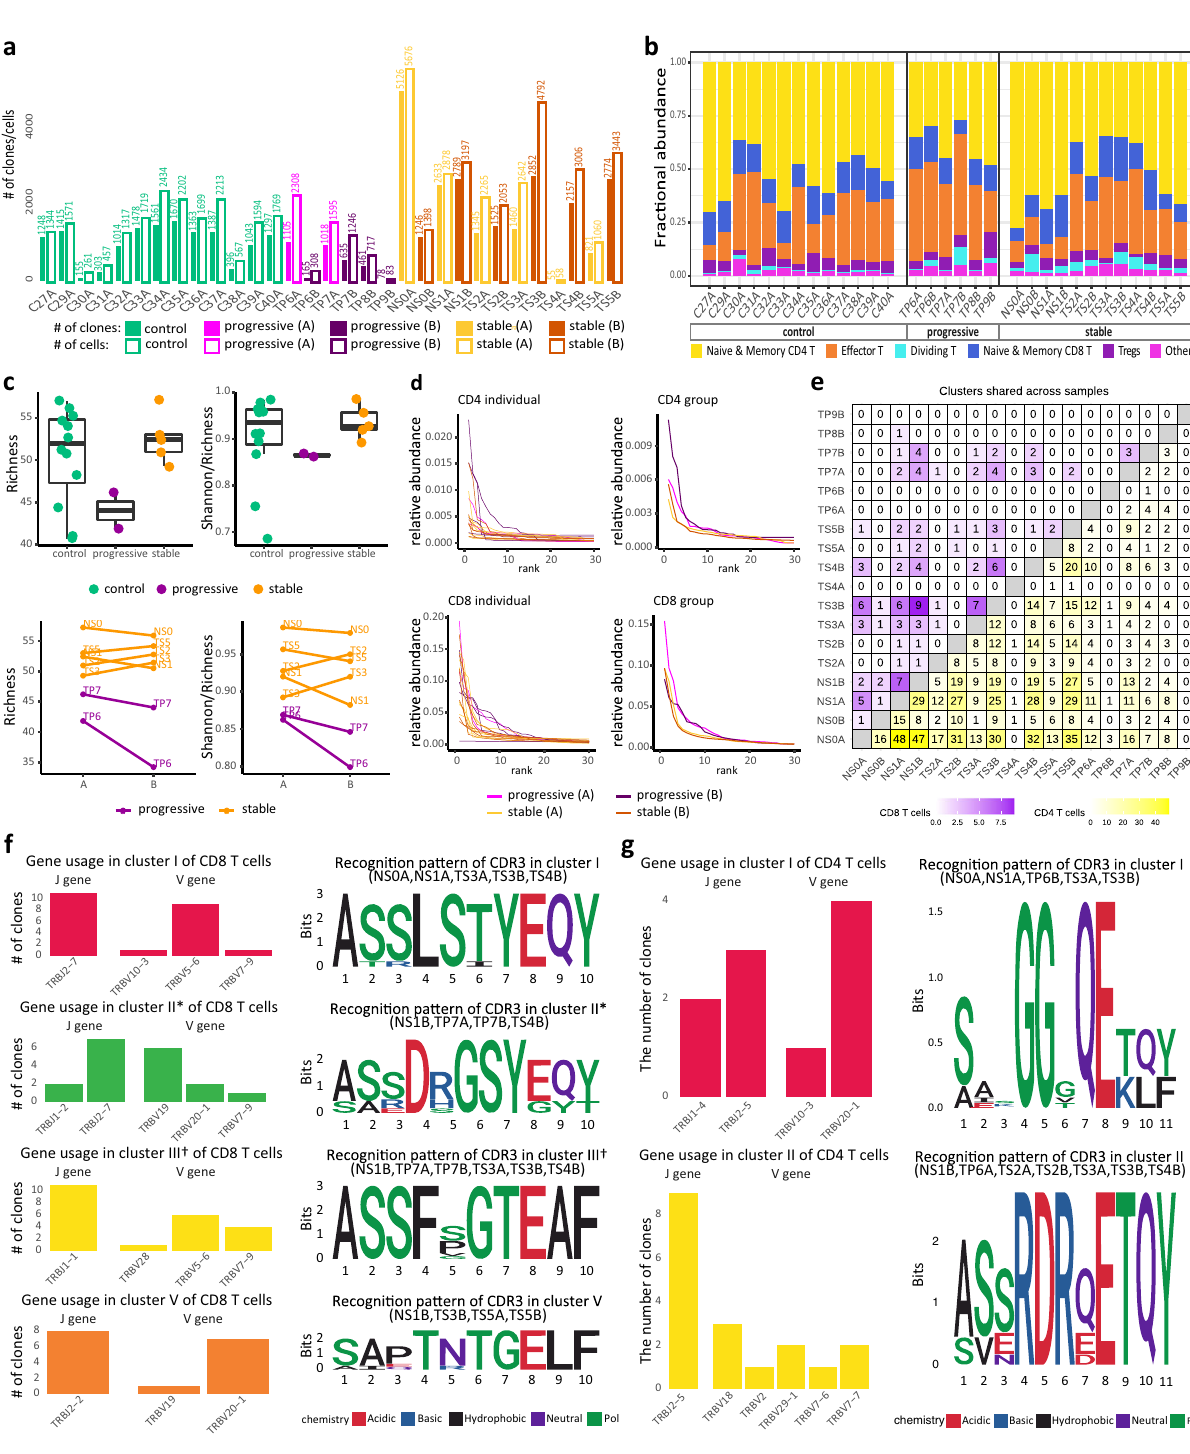
tocilizumab-progressive patients (mean = 58% across 5 samples, mean odds ratio = 1.2) (Fig. 8i). We further investigated the mutation frequency and CDR-H3 length of cells within ECs (Fig. 8d – f). We observed that the mutation frequency of IGHG plasma cells from stable patients was higher on average (mean = 5.5 ± 4%) than that in progressive patients (mean = 3.2 ± 0%), regardless of treatment status. The CDR-H3 length of IGHG plasma cells from stable patients was signi fi cantly larger than 15 AAs ( p -value < 0.01). In particular, patients without treatment